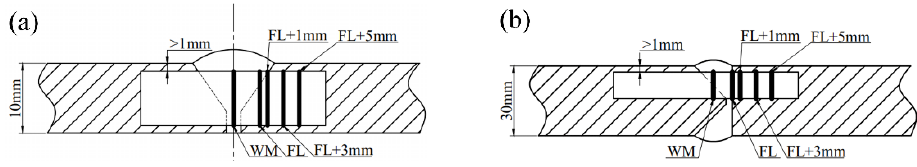
Figure 4. V ‐ notch location of the sample: ( a ) thickness of 10 mm; ( b ) thickness of 30